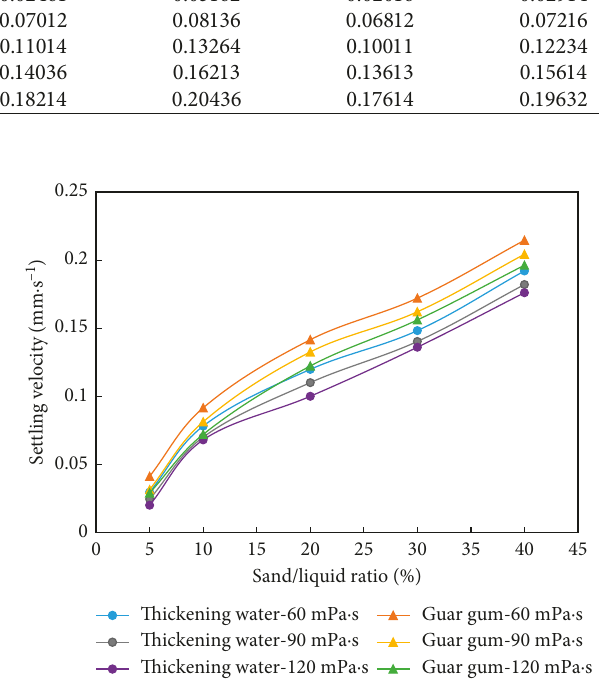
Figure 2: Comparison of static sand-carrying capacity of two kinds of fracturing